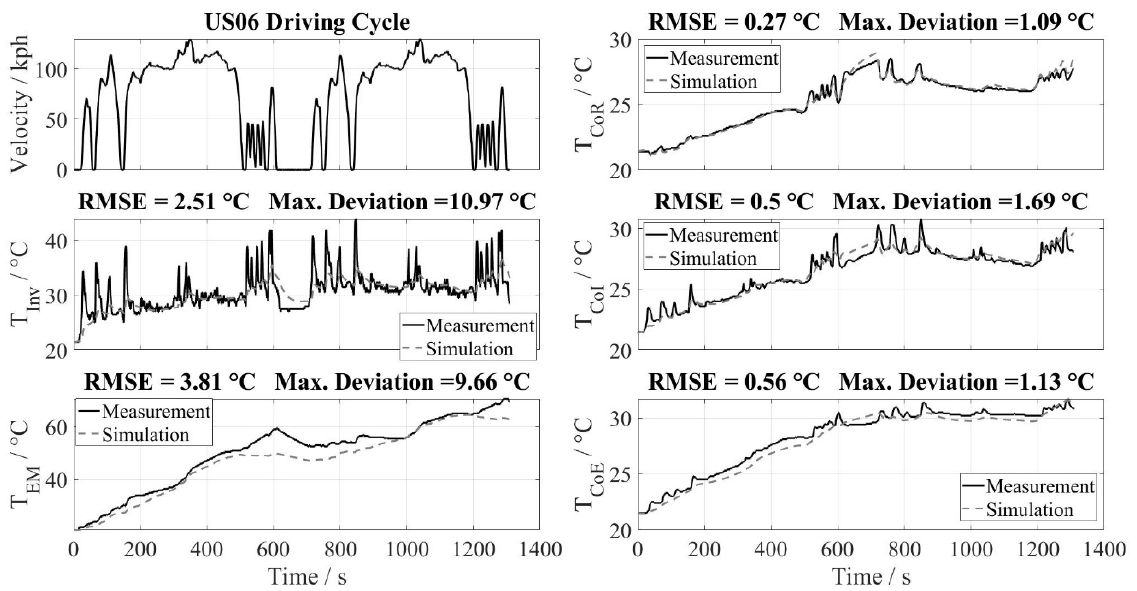
Figure 6. System validation of the transient temperature for the powertrain plant model based on the US06 driving cycle at an ambient temperature around 20 °C. US06 driving cycle at an ambient temperature around 20 ◦